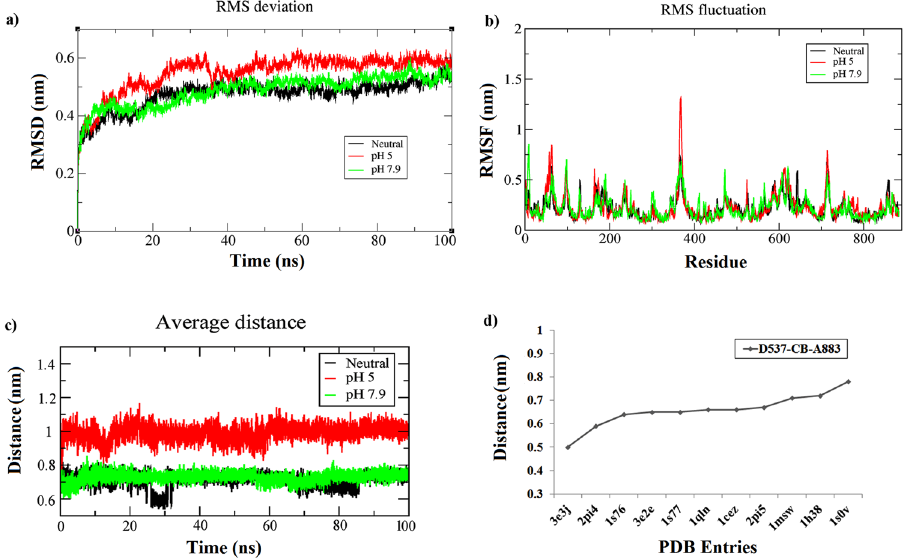
Figure 2. ( a ) Backbone RMSD plots for T7RNAP at three different pH values, ( b ) RMSF plots for T7RNAP at three different pH conditions. ( c ) Comparison of the average distance of C-terminal end to the catalytic core at different pH strengths, ( d ) distance of the D537 residues from C-terminal end in various experimental